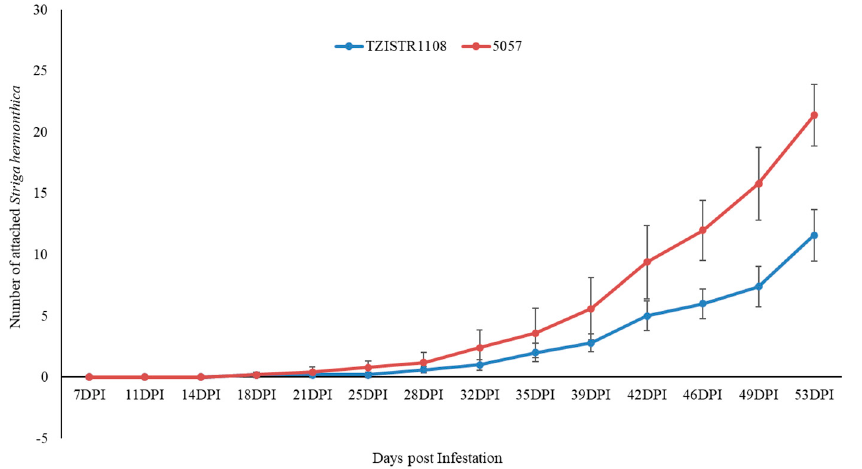
Figure 5. Mean number of attached Striga hermonthica on resistant (TZISTR1108) and susceptible (5057) maize lines in group B (GR24 treatment) as the experiment progressed. Error bars show standard error.